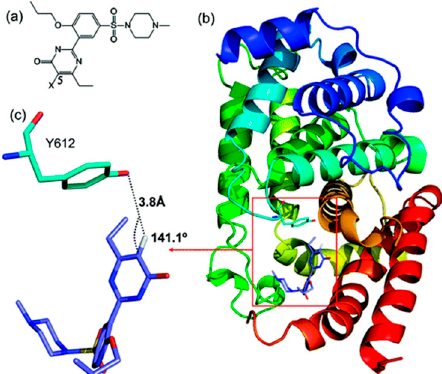
Figure 5. Structure and the binding mode of 1 (X = H) to PDE5 from the docking study. ( a ) Chemical structure of 1 ; ( b ) The docked structure of 1 –PDE5 complex. PDE5 is shown in cartoon form with Y612 represented in stick form in the boxed area. 1 is also represented in the boxed area in stick form; ( c ) For clear visualization, the hydrogen bonding between 5C-H in 1 and Y612 in PDE5 extracted from ( b ) is shown (figure has been reproduced with permission from